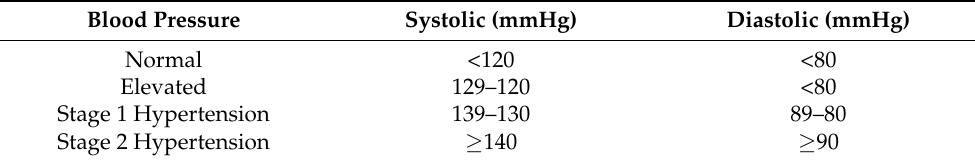
Table 1. Current blood pressure guidelines by American College of Cardiology